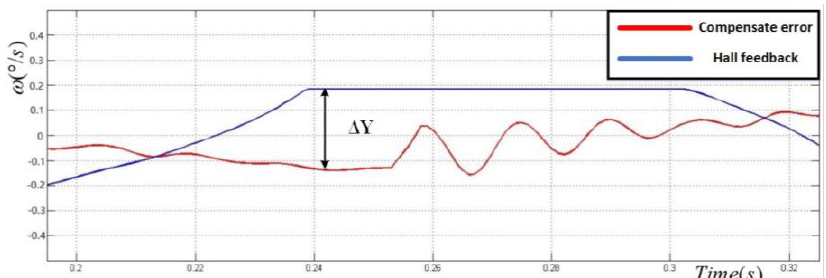
Figure 21. VCM controller disturbance suppression output.